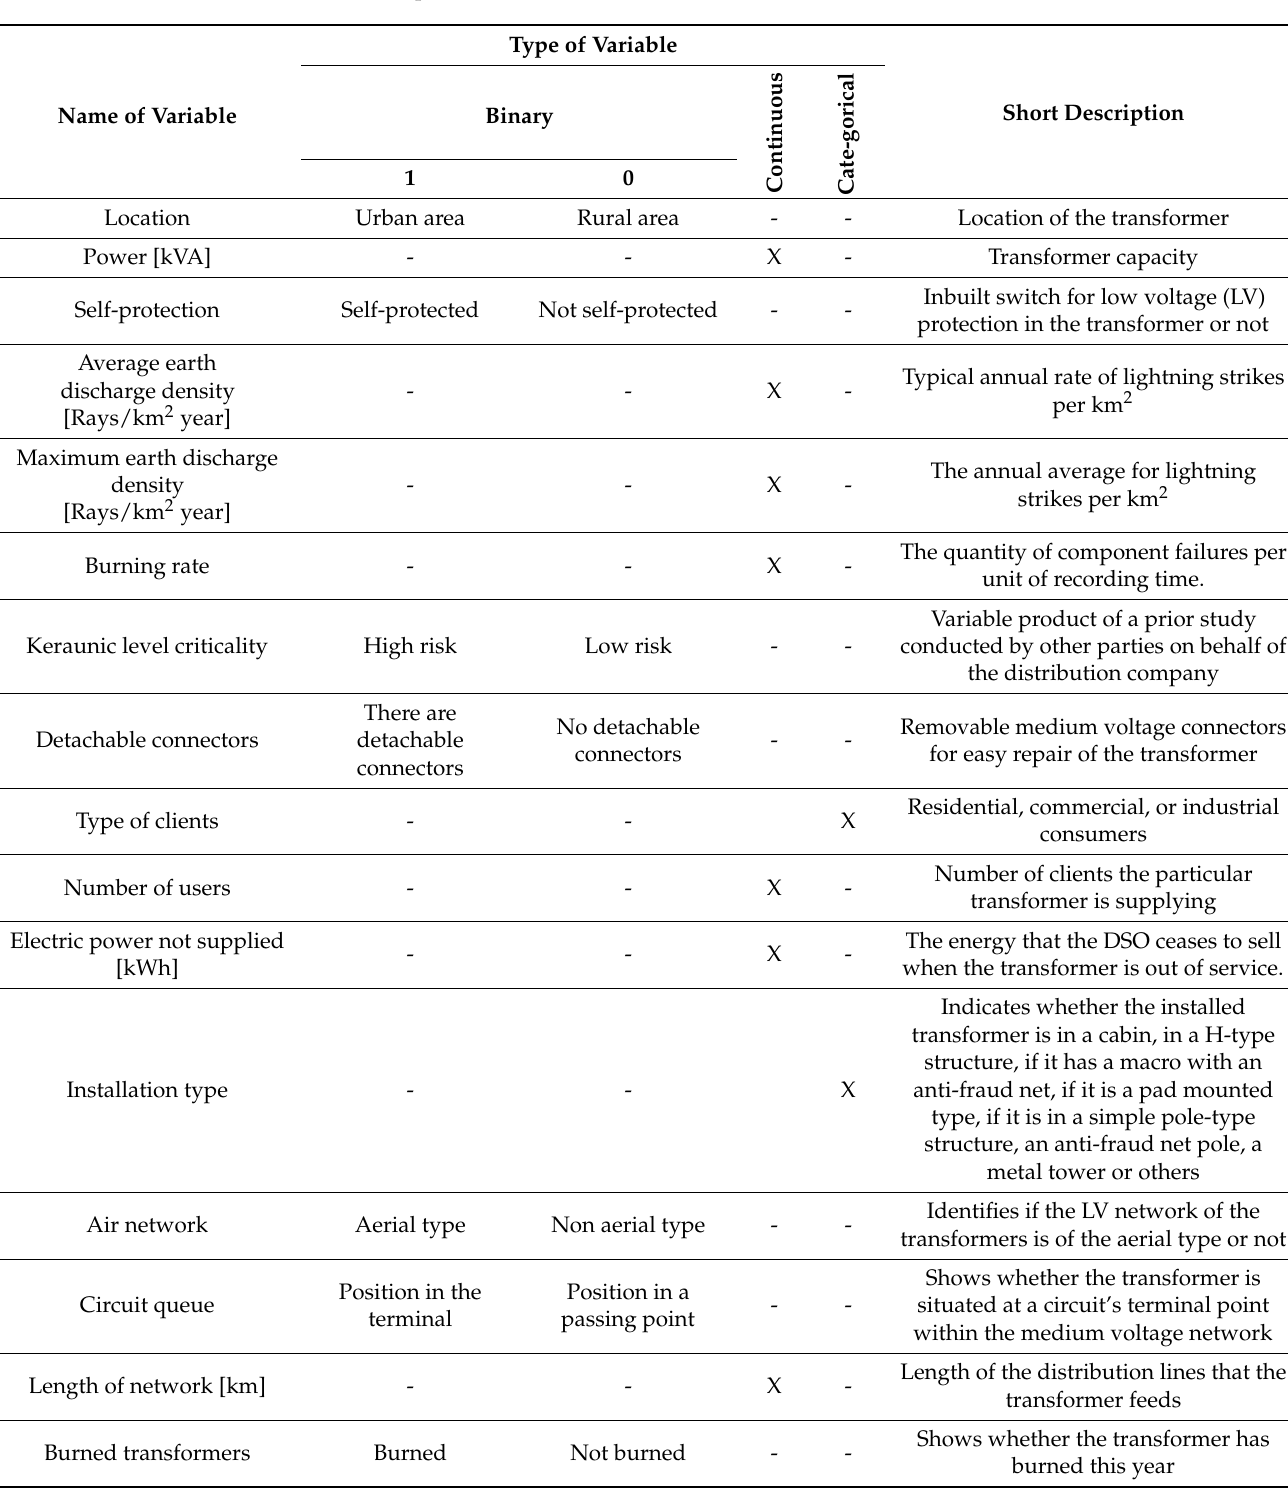
Table 1. Names and classification of variables for the dataset of distribution transformers of the Cauca Departments of